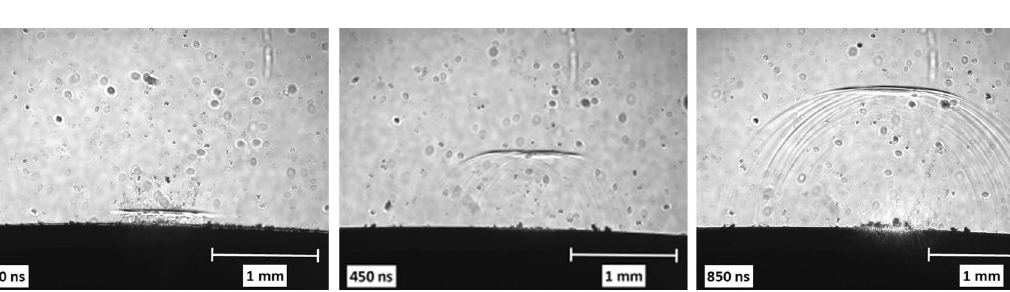
Figure 9. Fast photography images of pulsed laser ablation (λ = 532 nm, F = 3 J/cm 2 ) of meloxicam in distilled